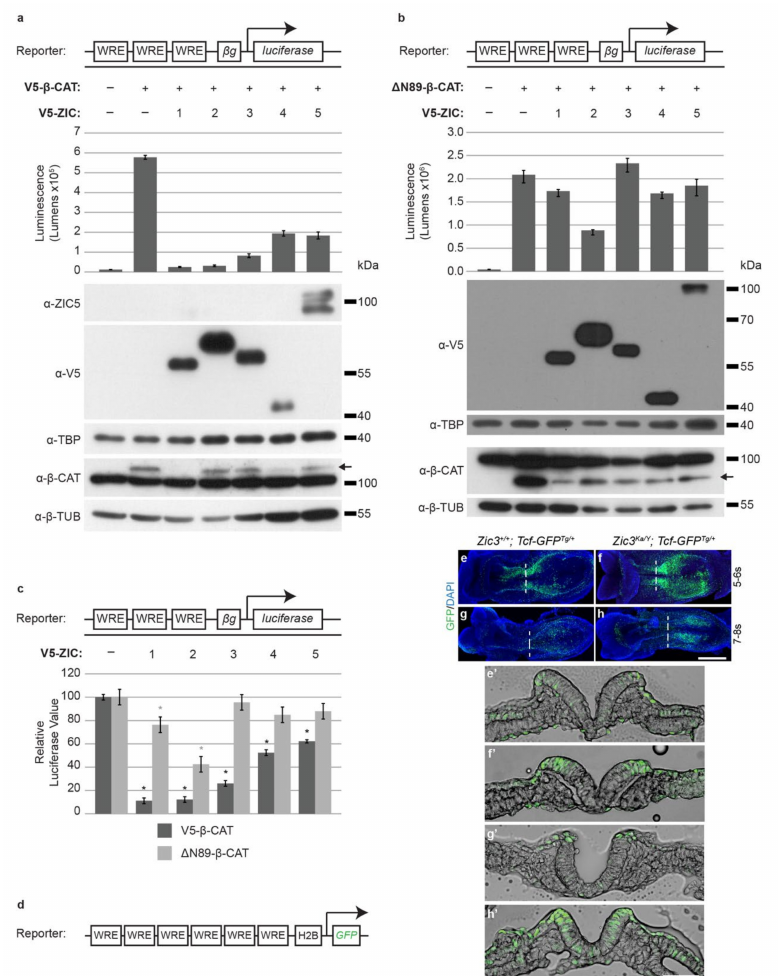
Figure 4. Context-dependent inhibition of WNT/ β -catenin-mediated transcription by the ZIC proteins. ( a – c ) Luciferase activity in HEK293T cells of the ZIC-optimized TCF-reporter construct shown driven by expression of epitope-tagged ZIC proteins (V5-ZIC1-5). WNT signaling was activated by transfection with ( a ) wild-type β -catenin (V5- β -CAT) or ( b ) stabilized β -catenin ( ∆ N89- β -CAT) to give higher activity. ( a , b ) Raw data and corresponding WBs of the overexpressed proteins from one representative experiment. Error bars denote ± s.d. of three internal repeats. For WB of nuclear fractions (using anti-V5 antibodies or anti-ZIC5-serum), antibodies against TBP were used as a loading control. For WB of cytoplasmic fractions (using anti- β -catenin antibody; α - β -CAT) antibody against β -tubulin ( α - β -TUB) was used as a loading control. The arrow in the β -CAT WB denotes the larger, tagged exogenous protein. Exogenous β -CAT is depleted to varying extents in the presence of the different ZIC proteins, which is consistent with the observation that ZIC3 overexpression enhances β -catenin degradation [46,56]. ( c ) Pooled data from the experiments shown in a and b presented relative to the value given by the respective empty-vector control transfections. In each data set the relative luciferase value of the β -catenin transfection is set to 100%. Error bars denote ± s.e.m. of three external repeats, *: p < 0.05, two-way ANOVA with Fischer’s unprotected post ad hoc test. Black asterisk, V5- β -CAT data; gray asterisk, ∆ N89- β -CAT data. Statistics to compare V5- β -CAT data and ∆ N89- β -CAT data were not performed. ( d ) Line diagram of the TCF/Lef:H2B- GFP mouse strain transgenic construct. ( e , f , g , h ) Dorsal view of wholemount embryos showing GFP (green) reporting TCF-mediated transcription and the DAPI (blue) nuclear stain. Scale, 200 µ m. ( e ’, f ’, g ’, h ’) Transverse sections at levels shown in corresponding image of embryos, showing GFP (green) reporting TCF-mediated transcription and a bright-field image of the section. The embryos’ genotype and stage are shown on each panel. Scale, 100 µ